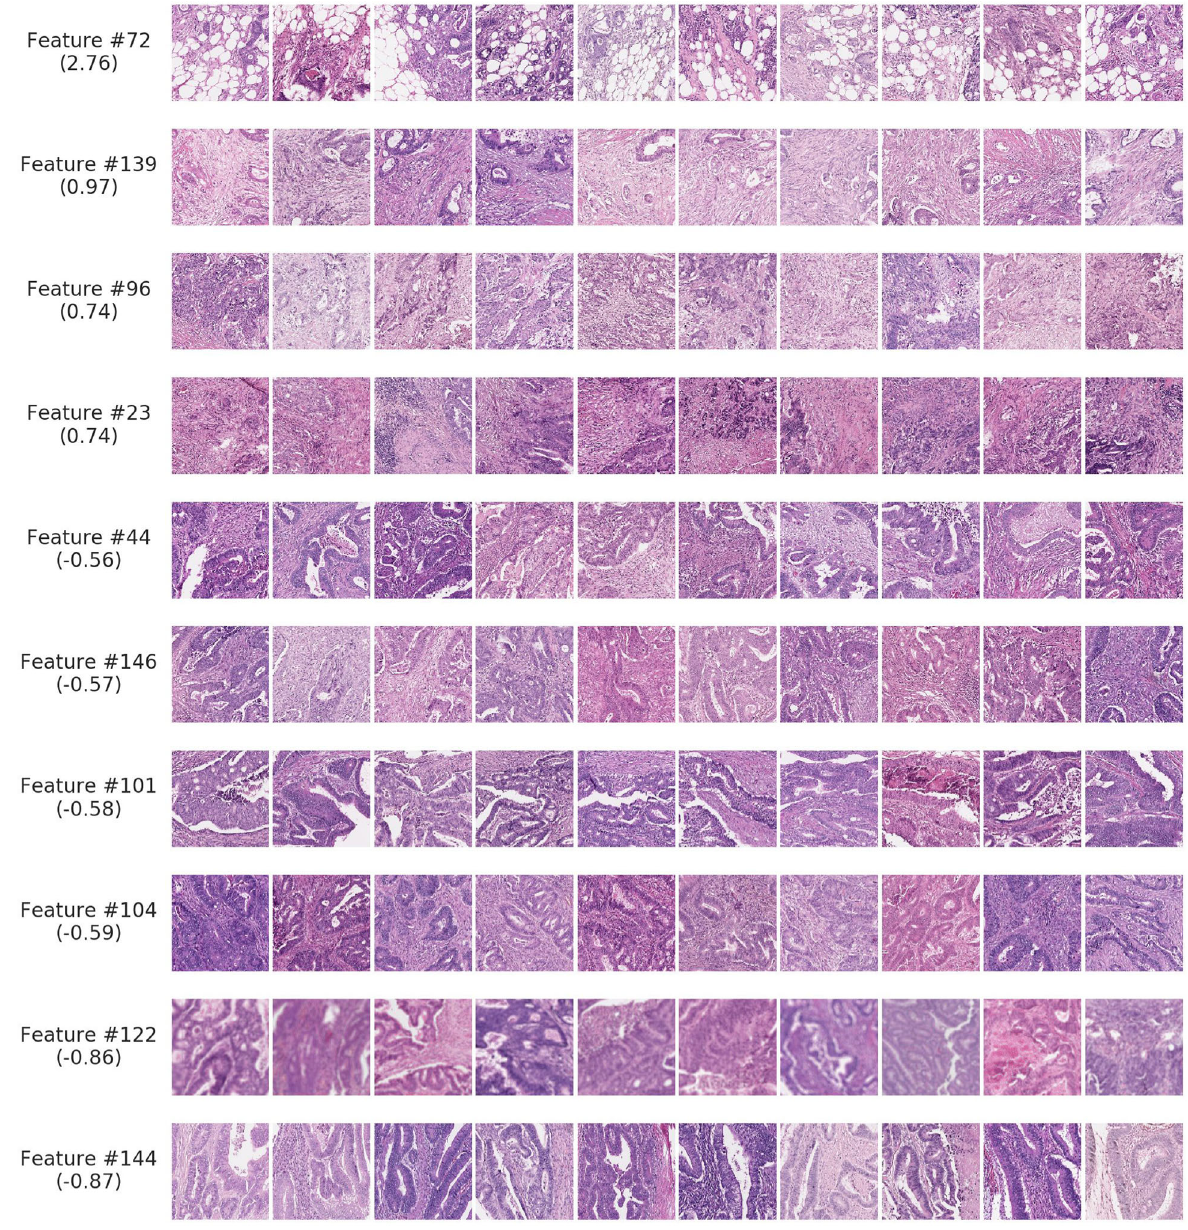
Fig. 2 Representative patches for clustering-derived features associated with predictions of the deep learning system (DLS). Sample patches for a set of 10 clustering-derived features are shown. For each feature, the ten patches closest to the centroid were selected, after fi ltering to ensure they were from distinct cases ( “ Methods ” ). The case-level quantitation of these 4 high-risk and 6 low-risk features explains the majority of the variance in case-level DLS scores. Features are ranked according to the average DLS score, which is provided in parentheses. Scale bar indicates 0.1